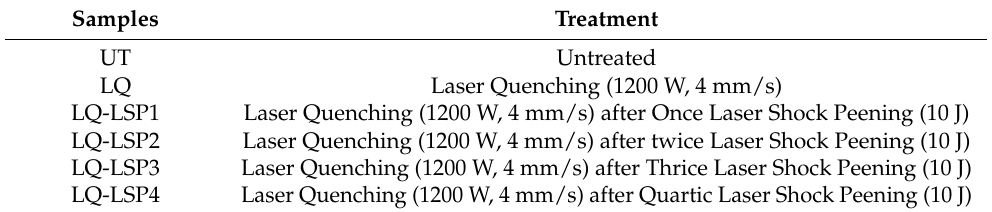
Table 2. Control group design of Cr12MoV laser quenching–shock peening composite strengthening